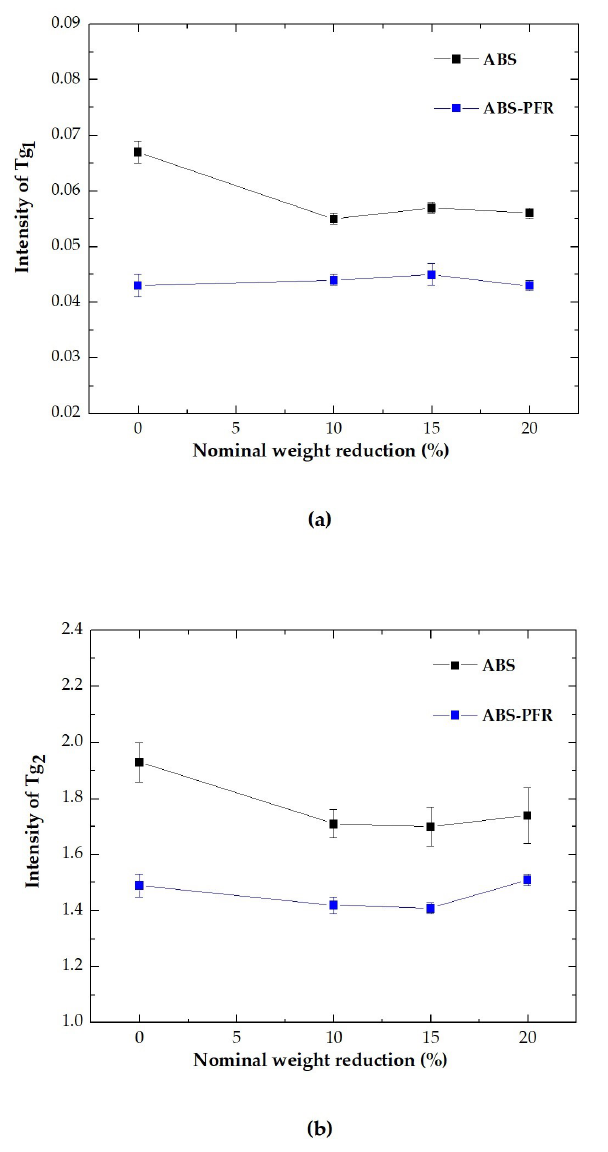
Figure 9. Variation of the intensity of tan δ of the ( a ) rubbery ( T g1 ) and ( b ) rigid ( T g2 ) phases of ABS and ABS/PFR with the nominal weight